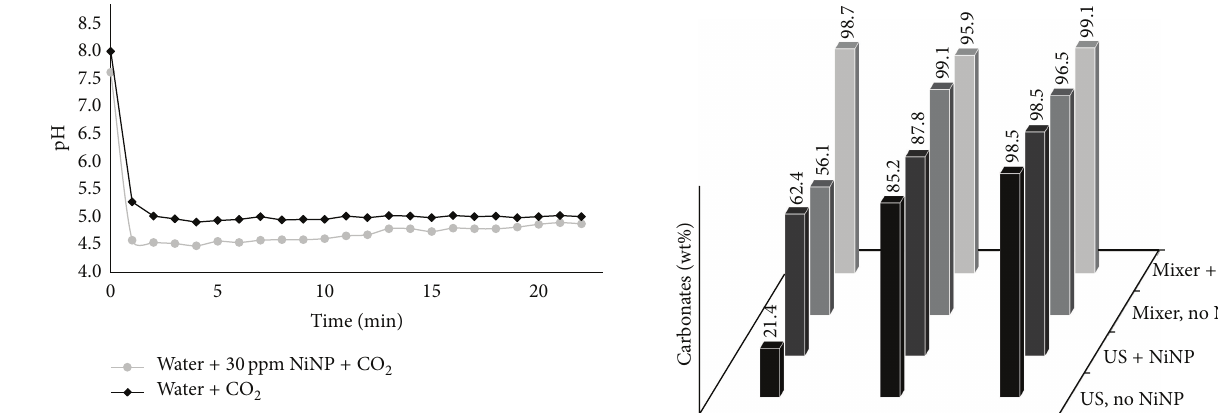
Figure 1: Evolution of pH value for ultrapure water with/without NiNP addition, after commencement of CO 2 bubbling at 50 ∘ C.